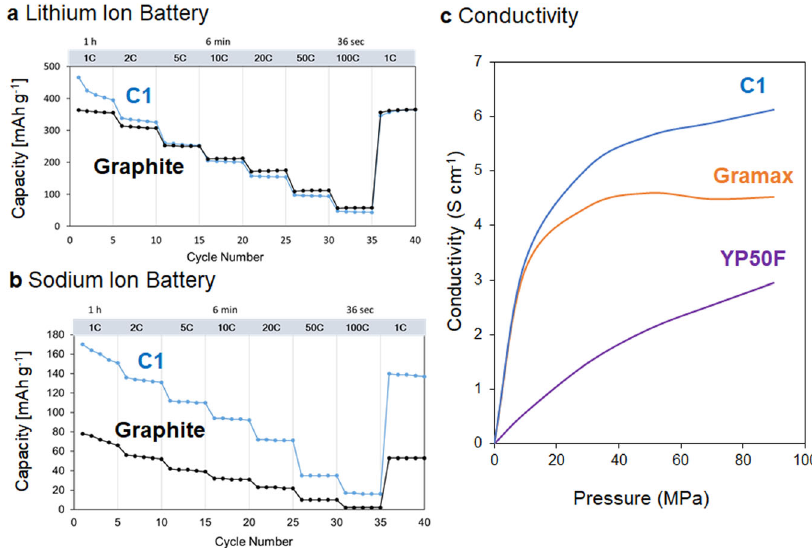
Fig. 4 Electronic property. Application of C1 as an anode active material for a lithium- and b sodium-ion batteries (1C = 372 mAh g − 1 ). As references, capacities of graphite are also shown. c Conductivity of the porous carbon C1 , Gramax (commercial anode material for a lithium-ion battery) and YP50F (commercial activated carbon for a supercapacitor